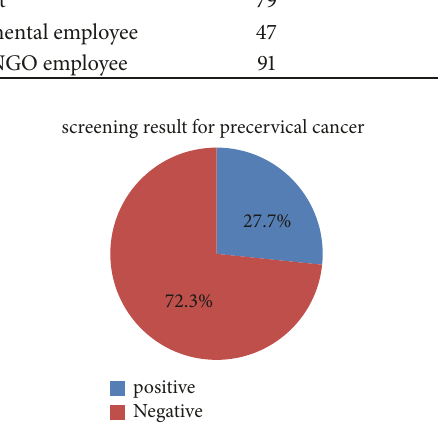
Figure 1: Magnitude of precervical screening among screened women in Arba Minch town and zuria district, Gamo Gofa Zone, SNNPR,